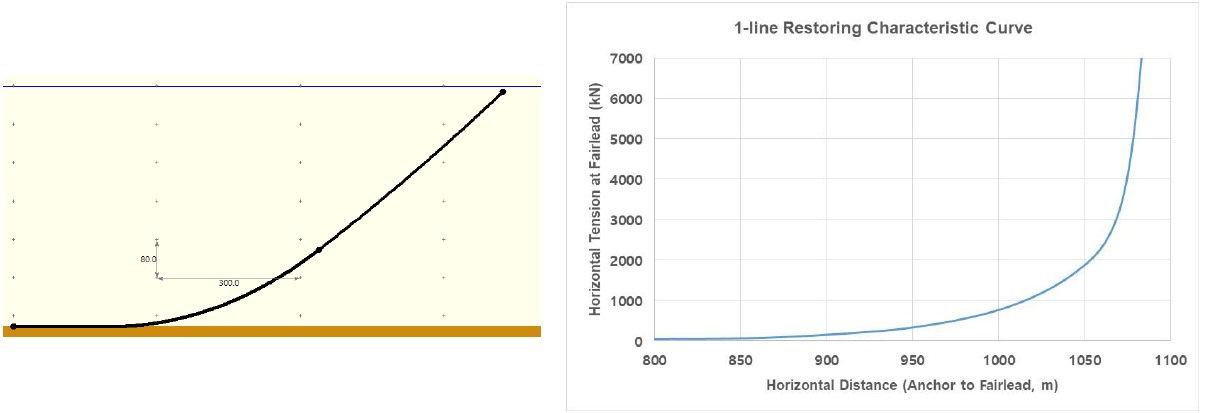
Figure 8. Optimized mooring line configuration ( left ) and its line characteristic ( right ), Case B.